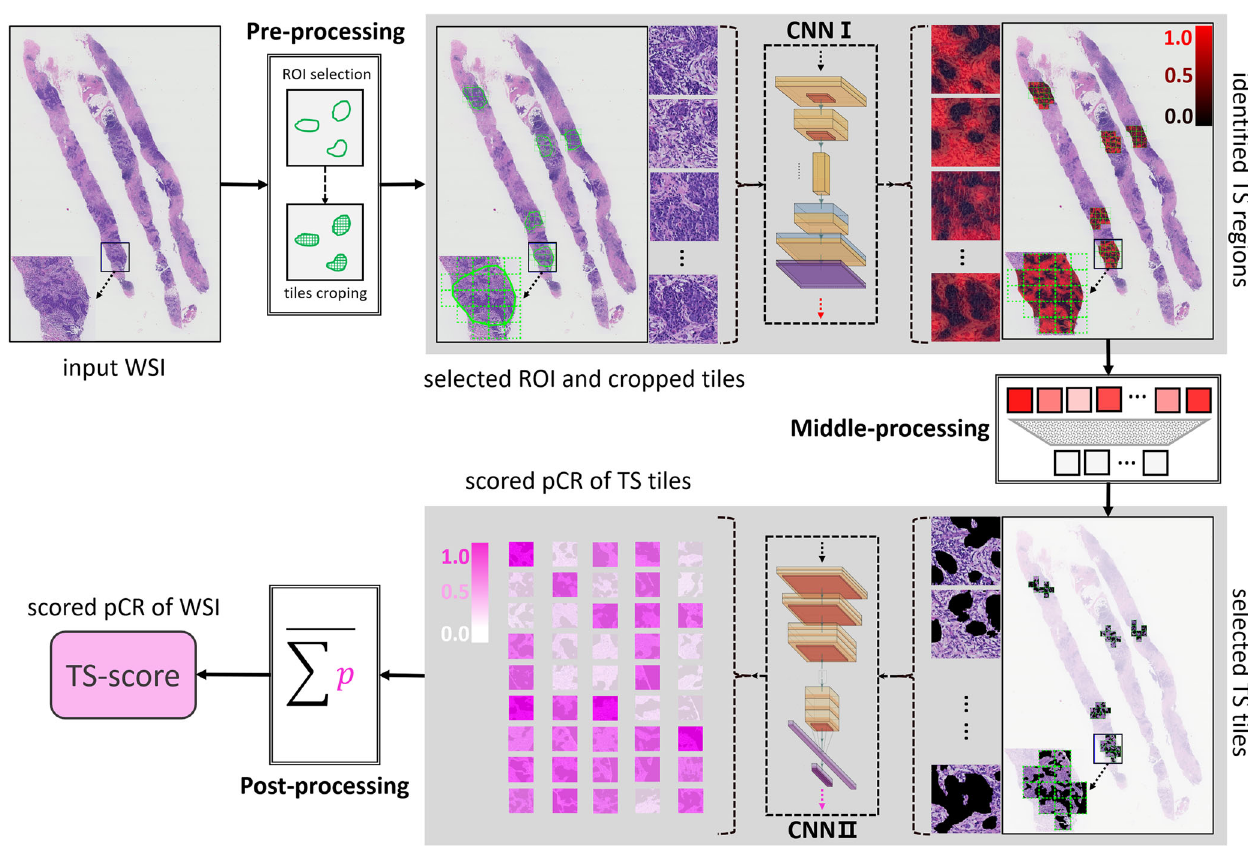
Fig. 2 Image processing pipeline to develop a stromal-derived biomarker for predicting pCR. In the pre-processing step, the digitized HE- stained slides were manually annotated and the ROIs were cropped as tiles (256 × 256 pixels at 10 × magni fi cation). With processed by the CNN I (also referring the E-S classi fi er), stromal pixels within the ROIs were detected and highlighted in red, and the color, red to black, indicates the probability of stroma from high to low. In the middle-processing step, a well-trained observer reviewed all tiles and removed the stromal tiles that did not exactly matched with the ground truth. Stroma tiles with identi fi ed by both the CNN I and the human observer were delivered to the CNN II and each tile was assigned with a score indicating the risk of achieving a pCR. In the post-processing step, all tile-level scores of each WSI were summed and the mean value was calculated and named TS-score, which was deemed as a DL-based biomarker derived from the stromal compartment and re fl ected the risk of pCR for breast